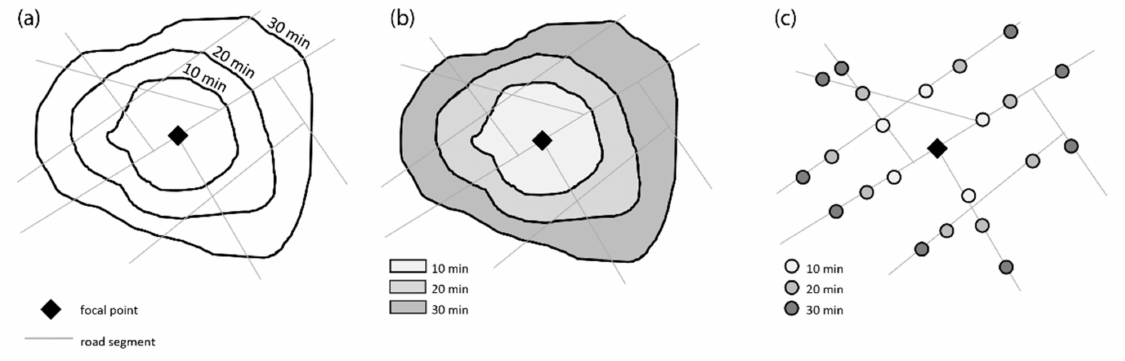
Figure 1. Visualization of accessibility: Isovarones ( a ), isovarone areas ( b ), network isovarones ( c